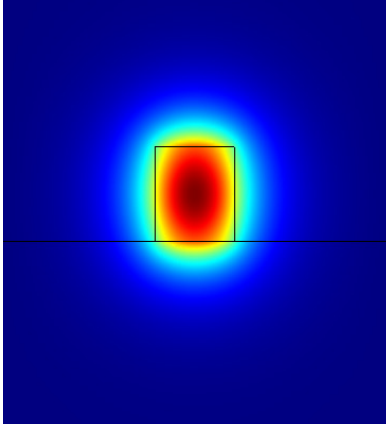
Figure 5 . Quasi-TM mode propagating in proposed sensor waveguide.